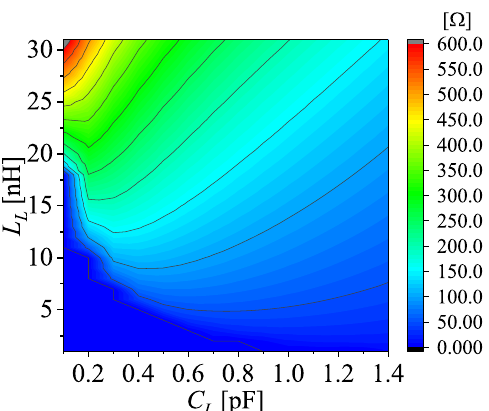
Fig. 7. Bloch impedance Z B at 1.5 GHz depending on C L and L L .